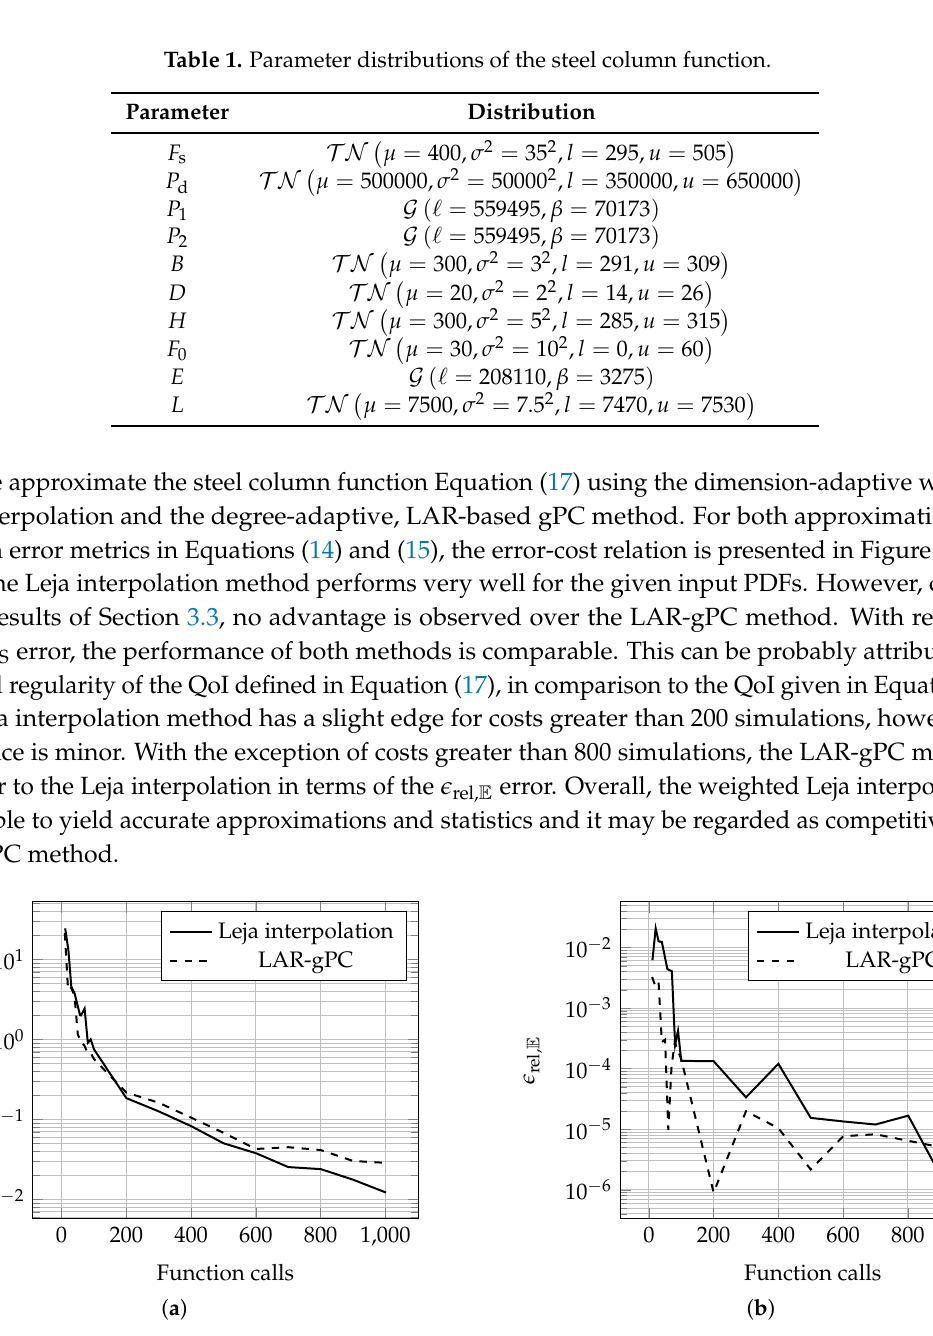
Figure 3. Cost-error relation for the approximations of the steel column function. The approximations are constructed with a dimension-adaptive weighted Leja interpolation algorithm [37] and with a degree-adaptive LAR-gPC algorithm [9,50]. The size of the validation sample is Q = 10 5 . The reference expected value is computed with quasi-MC integration based on a Sobol sample size equal to 10 8 : ( a ) RMS validation error, ( b ) Expected value relative